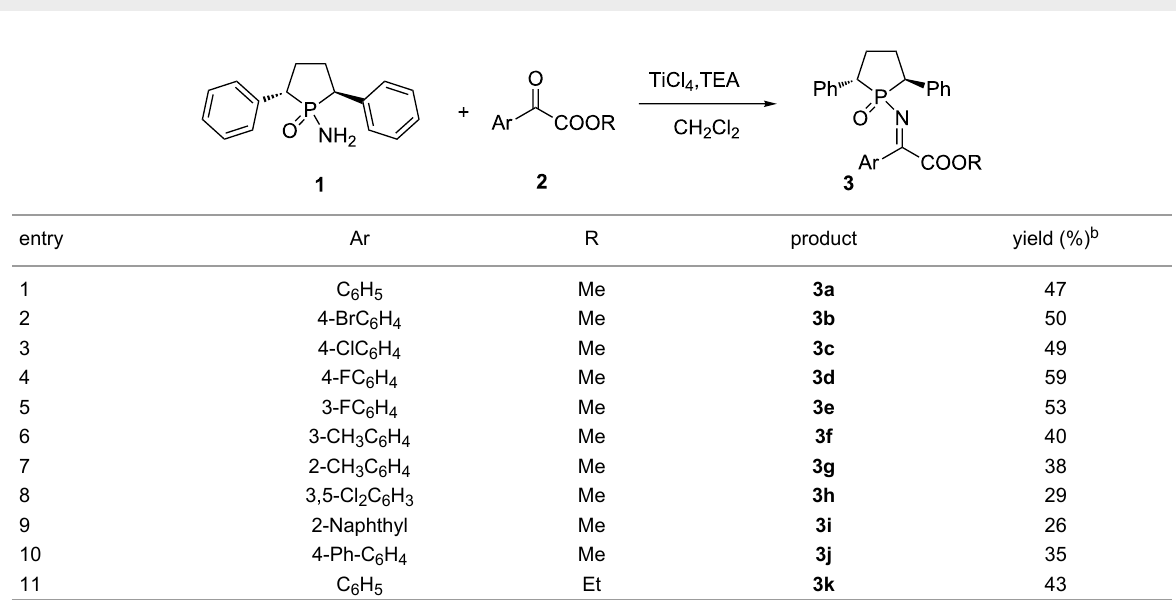
Table 2: Synthesis of N -phosphinyl-protected α -imino esters a